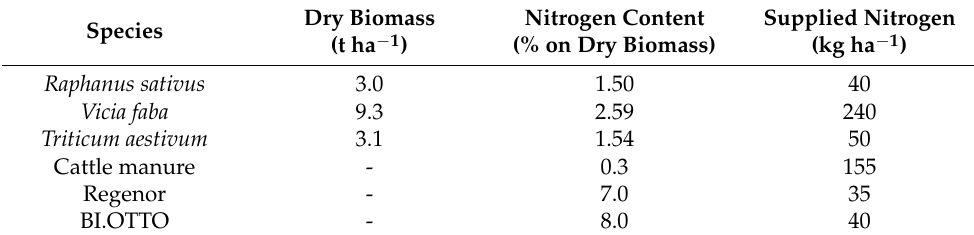
Dry Biomass Nitrogen Content (t ha − 1 ) (% on Dry Biomass)